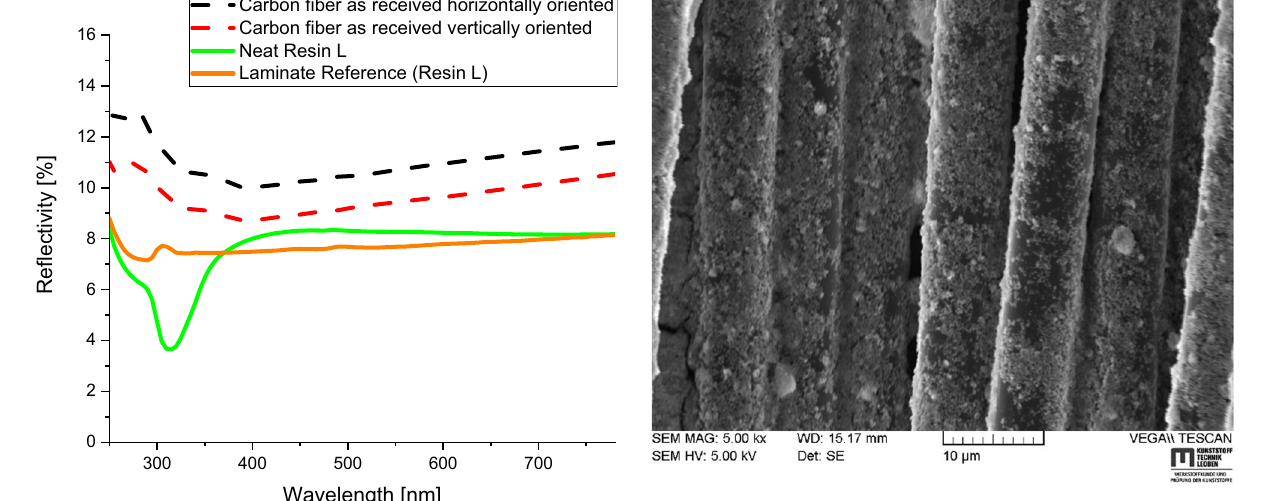
Figure 9: Re fl ectivity measurements of referenece materials ( Hexcel 12k AS4 carbon fi ber, neat epoxy Resin L, and manufactured laminate ) .